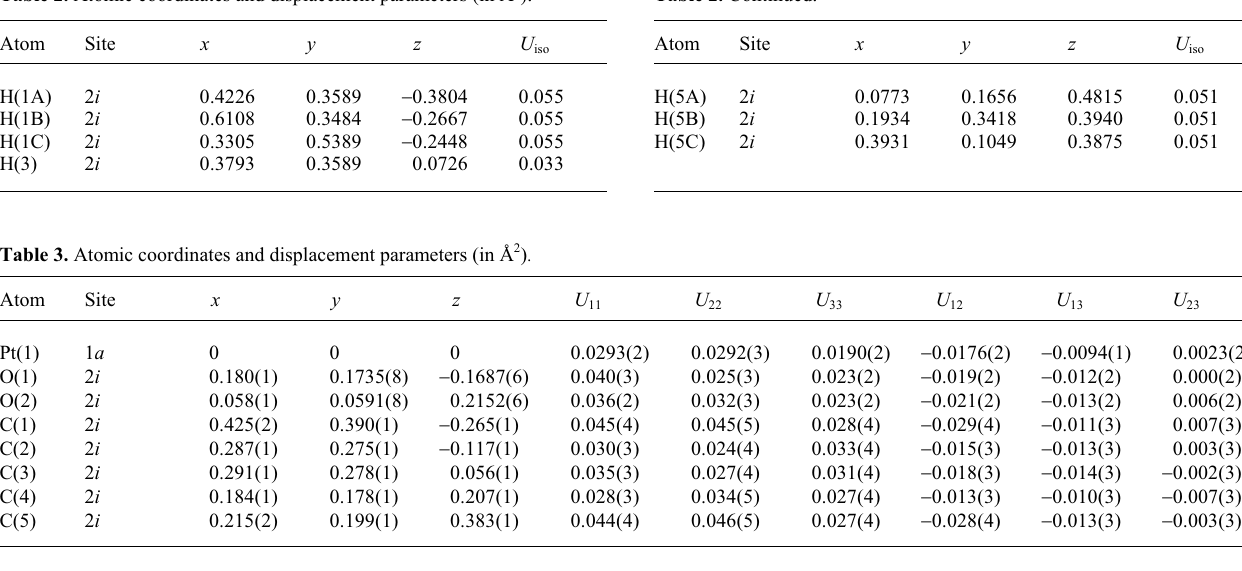
Table 2. Atomic coordinates and displacement parameters (in Å 2 )